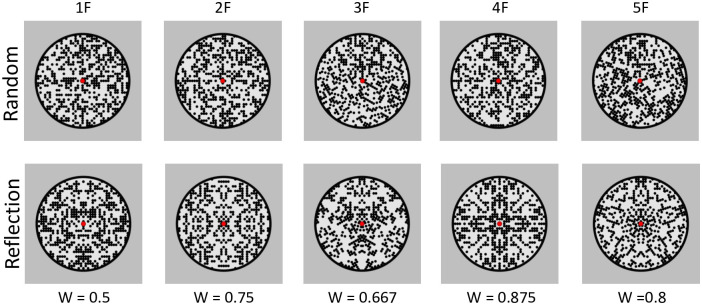
Example stimuli and W scores from the holographic model.